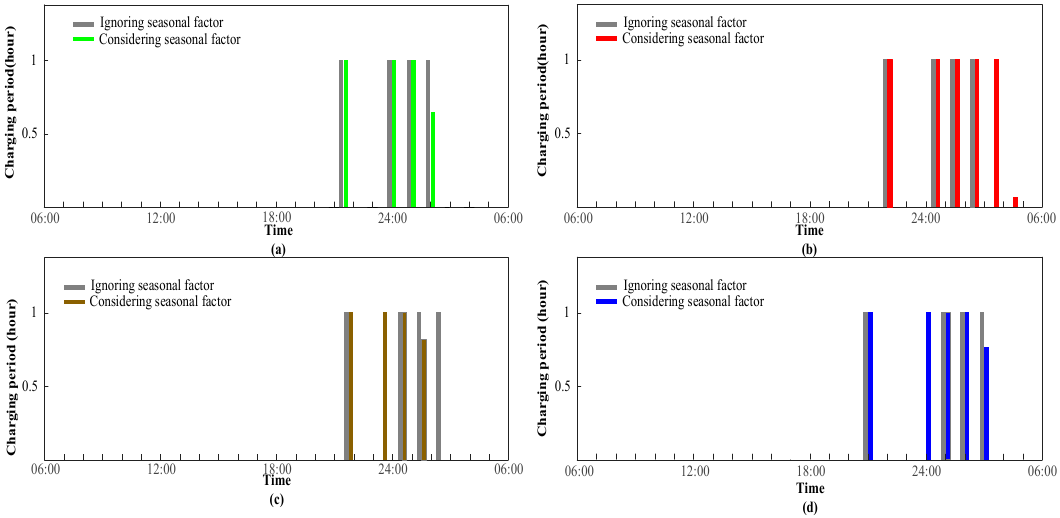
Figure 12. Optimal charging strategy for a selected domestic electric vehicle in different seasons; ( a ) spring, ( b ) summer, ( c ) autumn, ( d ) winter. Table 3. A summary of the given network transmission loss under different conditions.